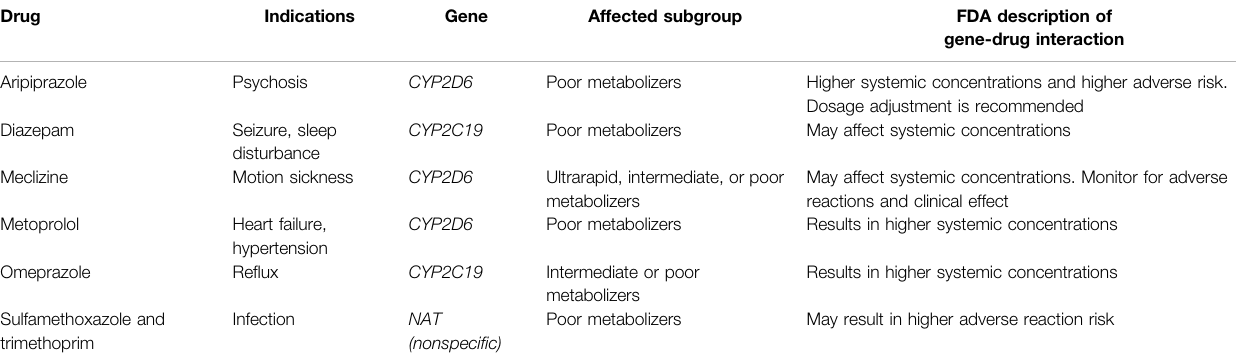
TABLE 2 | Drugs that are part of the ISS formulary with FDA acknowledged pharmacogenetic